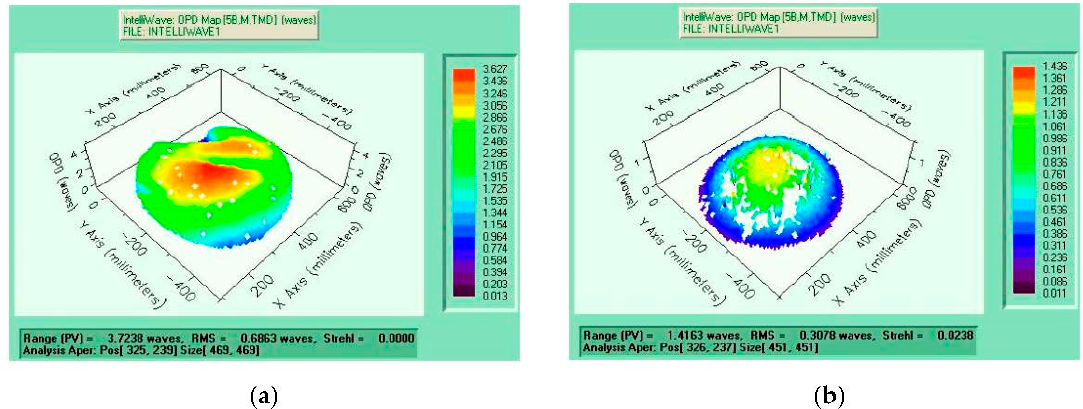
Figure 18. The flatness of sapphire: ( a ) traditional CMP and ( b ) DEPP.